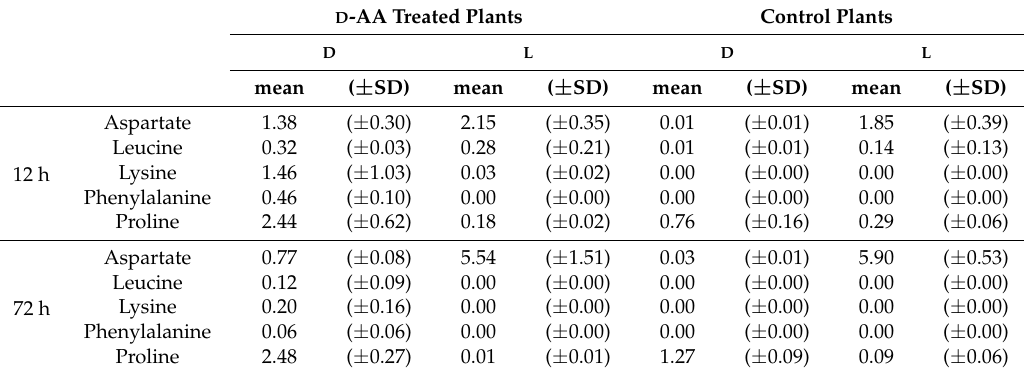
Table 1. D - and L -AA contents of media (in nmol/well) 12 and 72 h after 24 h treatment in different D -AAs and transfer to fresh media. D -AA Treated